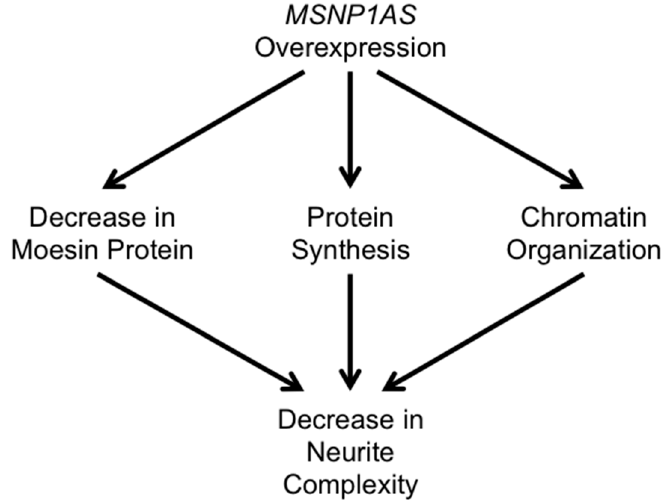
Figure 4. Potential mechanisms by which MSNP1AS alters neuronal architecture. MSNP1AS overexpression decreases the expression of moesin protein, as well as the expression of genes involved in protein synthesis and chromatin organization, leading to a decrease in neurite